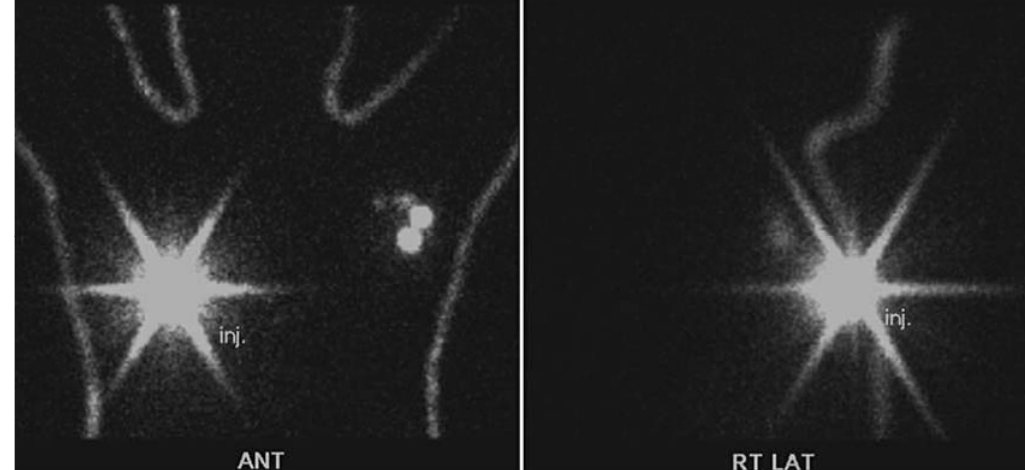
Figure 2. Aberrant drainage to the contralateral axilla and not on the ipsilateral axilla. ANT, anterior; RT, Right; LAT, lateral.